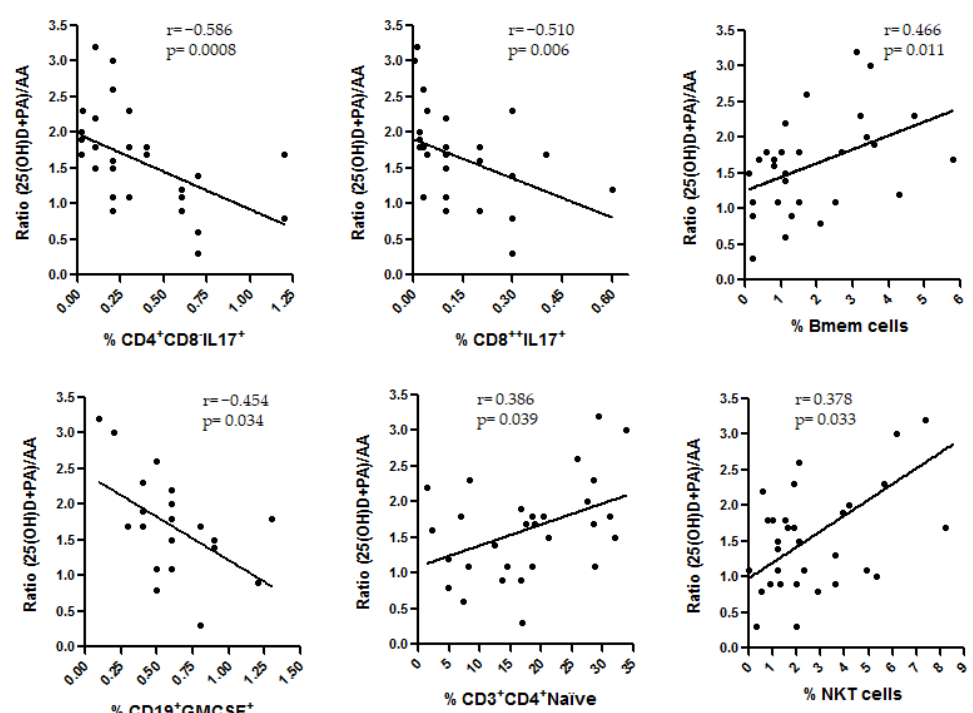
Figure 4. Significant correlations among (25(OH)D+PA)/AA algorithm and the cell subsets analyzed in untreated MS patients; p -values (Mann–Whitney U-test) and Spearman’s rank correlation coefficient (r) are shown.